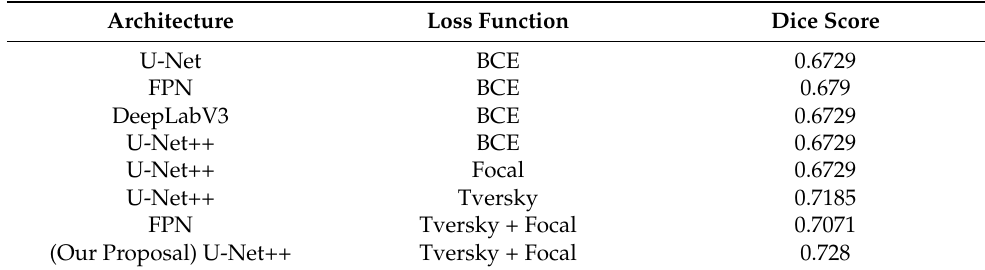
Table 4. Experimental results.